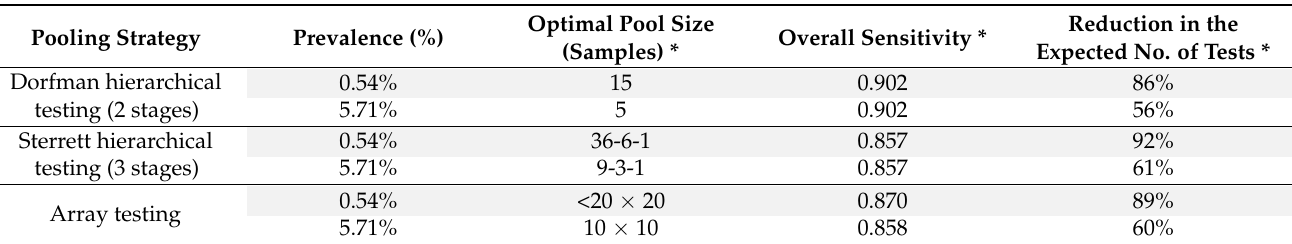
Table 1. The optimal pool size, the overall sensitivity, and the reduction in the expected number of tests in three different pooling strategies, based on the prevalence of COVID-19 disease observed in a cohort of asymptomatic oncological patients (prevalence: 5.71%; n = 471) and among asymptomatic medical staff (prevalence: 0.54%; n =